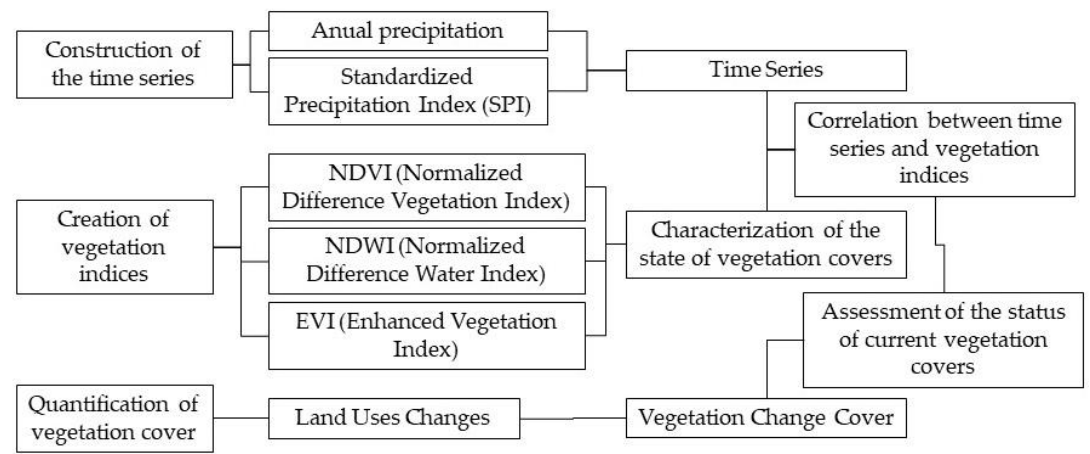
Figure 5. Workflow.